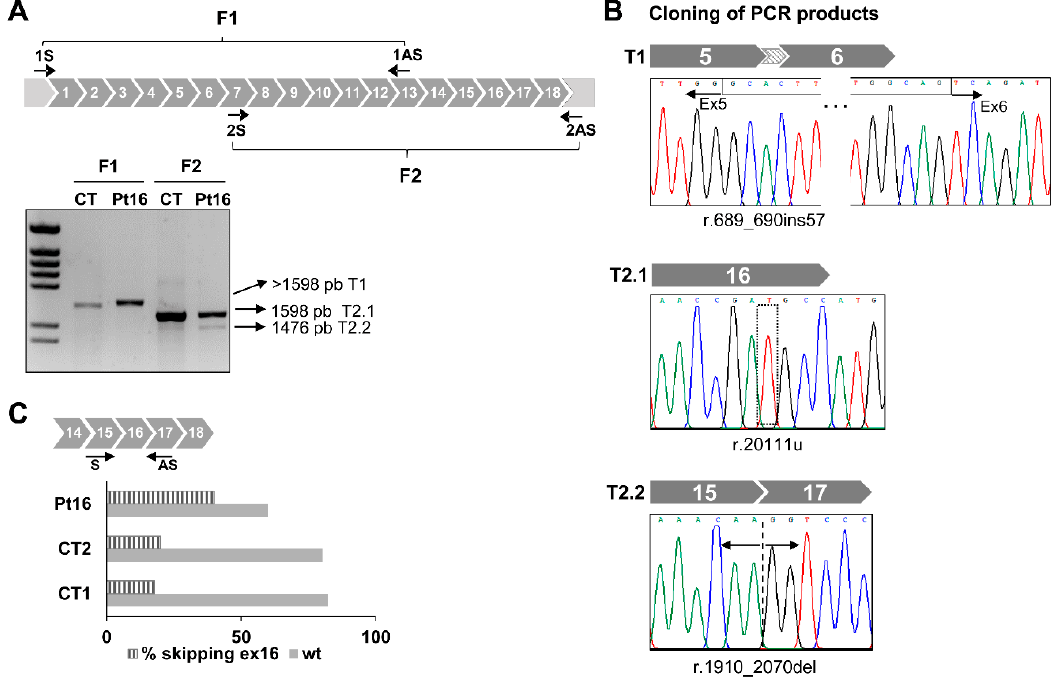
Figure 2. Aberrant splicing of GFM1 in Pt16. ( A ) Diagram of GFM1 cDNA with primers (arrows) used to amplify the complete coding region in two overlapping (F1 and F2) fragments. Agarose gel showing the results of RT-PCR amplifications in control (CT) and patient (Pt) fibroblasts. ( B ) Cloning of F1 and F2 PCR products and Sanger sequencing of regions around the nucleotide variations detected. ( C ) Distribution of reads. Data represent the percentage of GFM1 transcript reads with exon 16 skipped (stripped bars) and full length (filled bars). Read numbers were 41,758 for Pt16, 13,581 for CT1 and 16,718 for CT2.